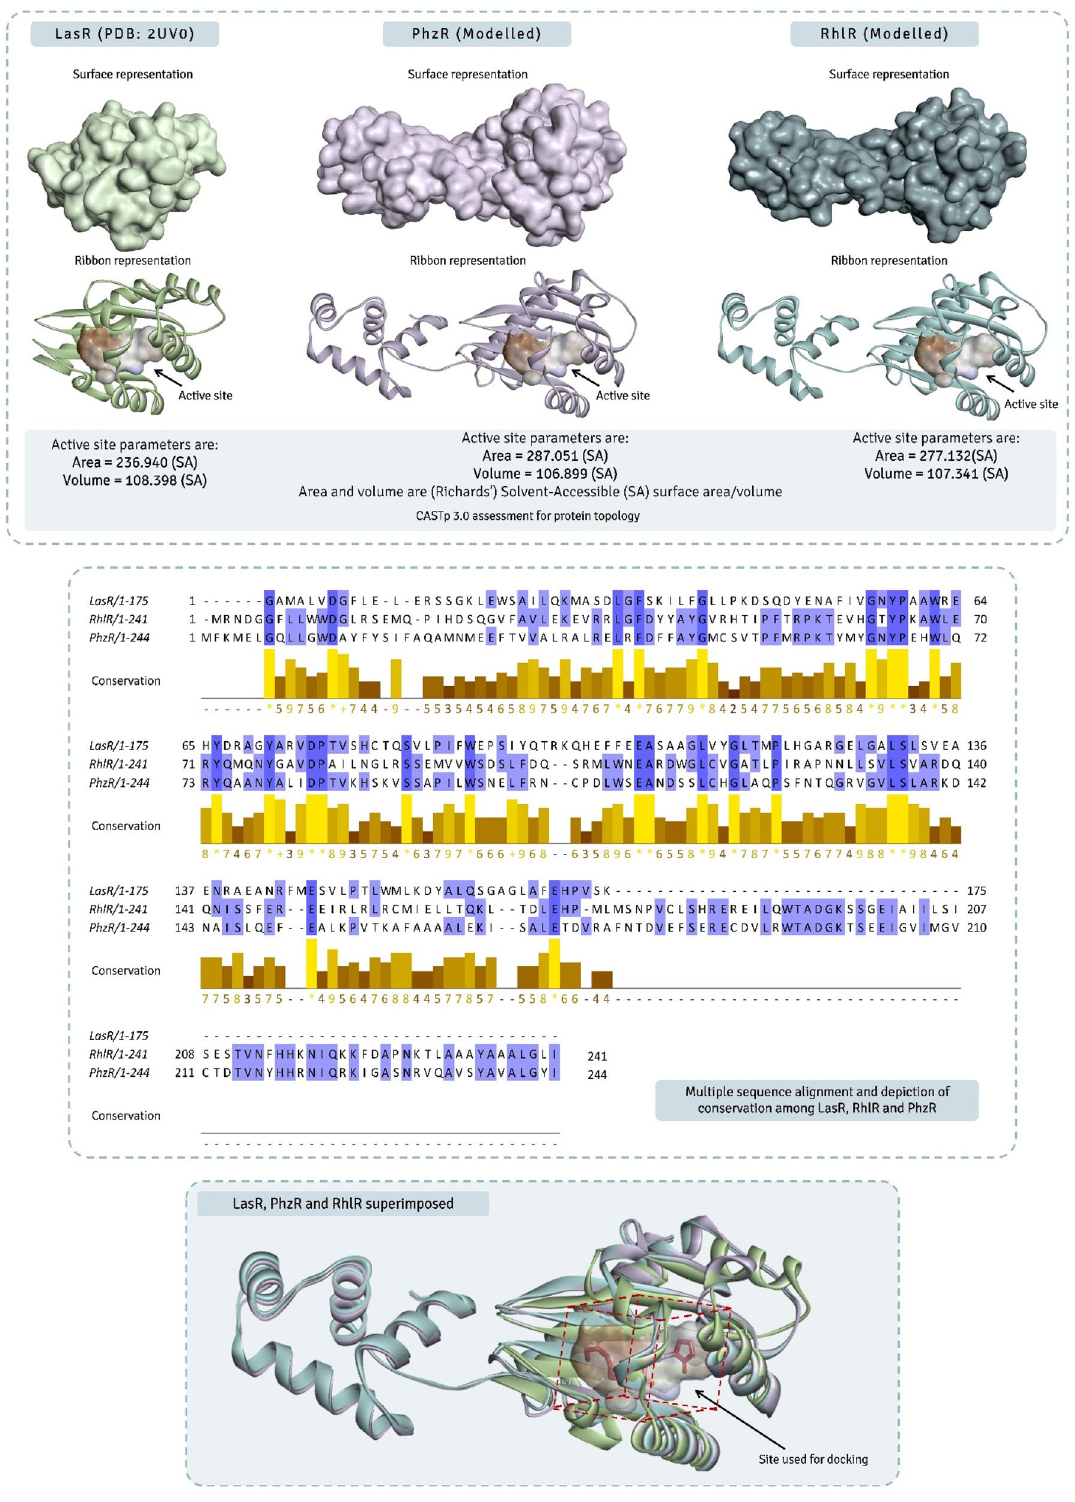
Figure 2. Structural and sequence comparison of LasR, PhzR and RhlR, further superimposition of all three proteins and identifying their accurate active